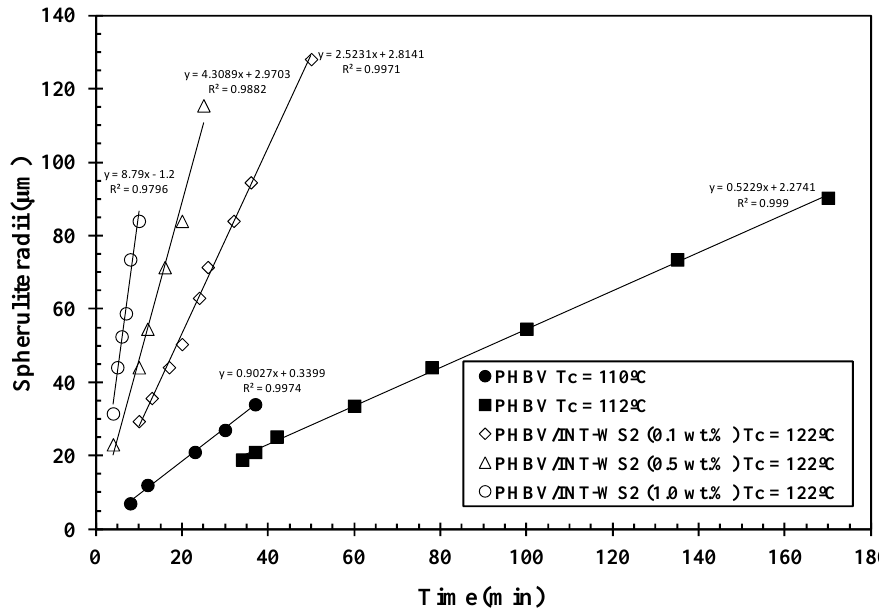
Figure 8. Isothermal spherulitic radii of PHBV/INT-WS 2 nanocomposites obtained at the indicated crystallization temperatures.